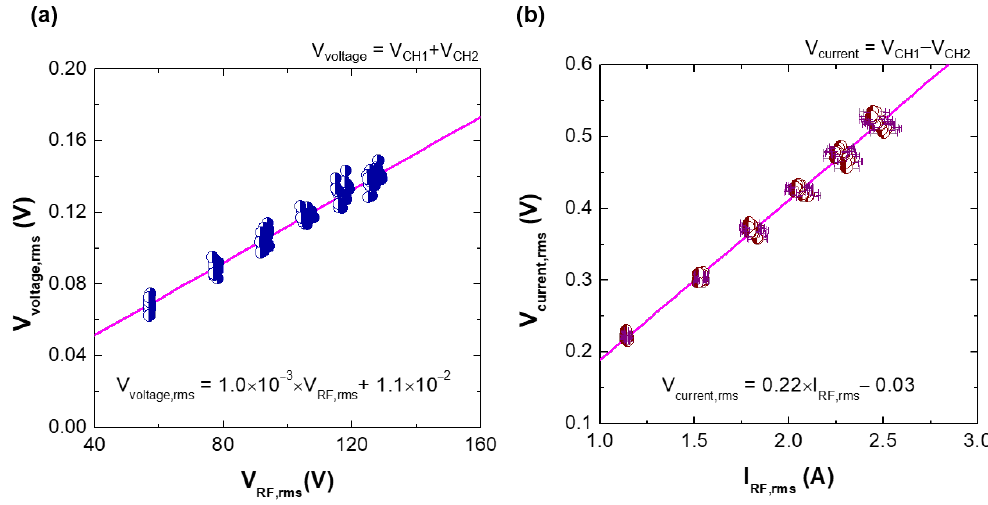
Figure 9. Calibration results of the ( a ) voltage and ( b ) current along increasing RF input voltage and current. To avoid impedance variation by plasma formation during the calibration procedure, the pressure of the vacuum chamber is maintained below 1 mTorr (lower than the minimum measurable range of the vacuum